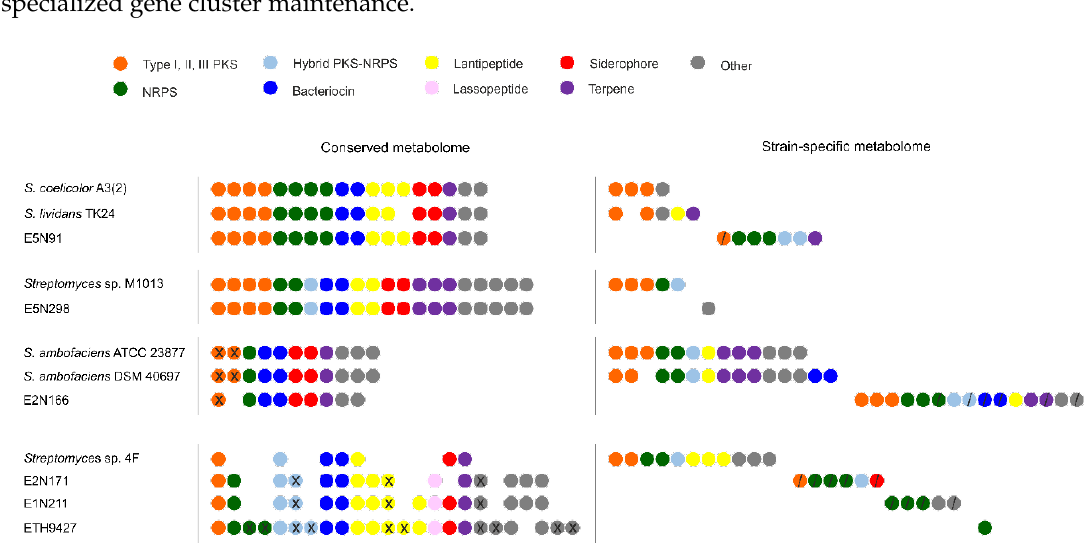
Figure 4. Conserved and strain-specific biosynthetic gene clusters. Within each clade, conserved and strain-specific gene clusters (circles) were identified. Original chromosomal organization is not considered, and clusters with the same position are identical. Colors represent the major classes of specialized metabolites: Type I, II, and III PKS (orange), NRPS (green), hybrid PKS–NRPS (light blue), bacteriocin (dark blue), lantipeptide (yellow), lassopeptide (pink), siderophore (red), terpene (purple), and others that include other KS pathways and less common metabolites such as phenazines, butyrolactones, and indoles (grey). Unknown clusters are indicated with “/” and duplicated clusters with “X”.